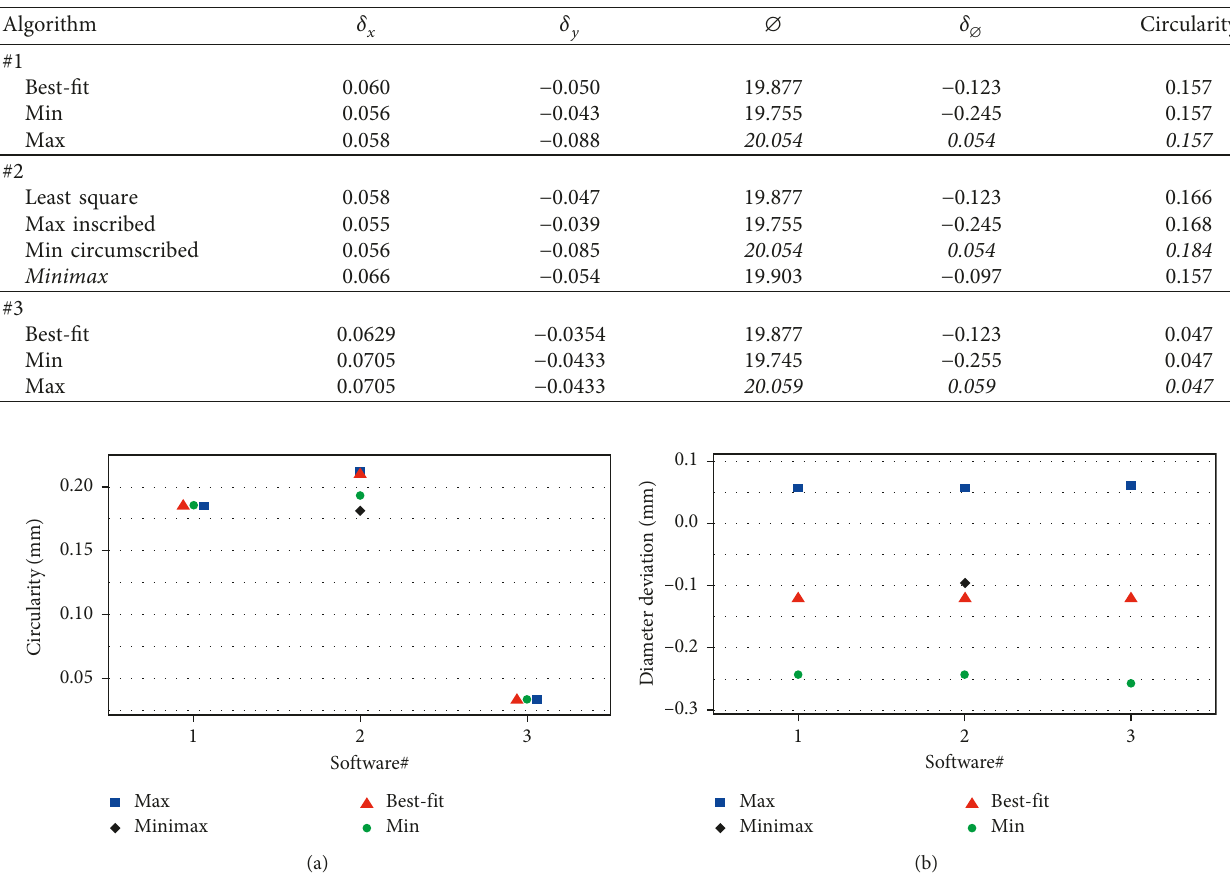
Table 2: Results of inspection circle #1 ( ∅ 20mm).